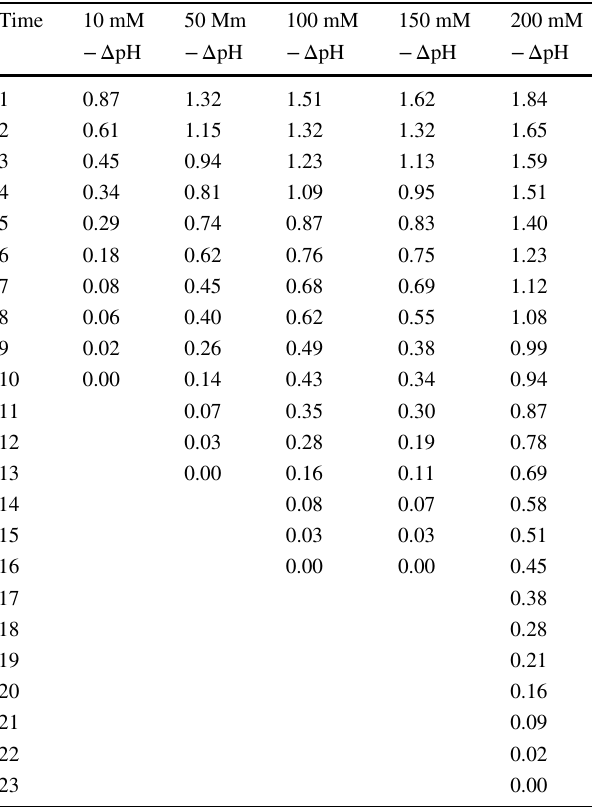
Table 3 pH variation after mixing for aqueous solution containing cadmium(II)